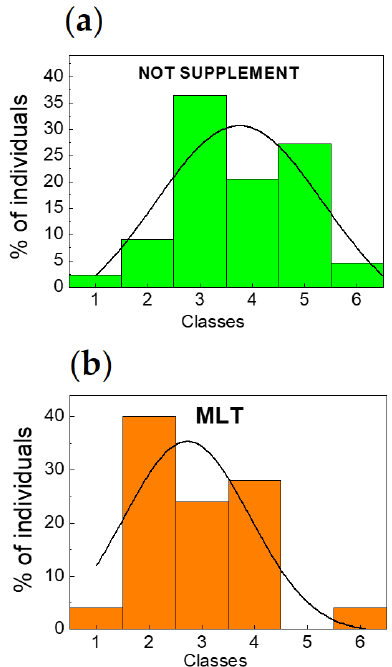
Figure 3. Individuals ( % ) vs. classes compared to a Gaussian fit distribution. ( a ) Percentage of individuals who have not received supplement (green histograms) vs. classes compared to a fitting Gaussian distribution (black continuous curve). ( b ) As in ( a ) but for individuals who have received MLT (orange histograms). In both panels the meaning of classes in terms of number of leukocytes is: 1 ⇔ 4000–5000/µL, 2 ⇔ 5000–6000/µL, 3 ⇔ 6000–7000/µL, 4 ⇔ 7000–8000/µL, 5 ⇔ 8000–9000/µL, 6 ⇔ 9000–10,000/µL.